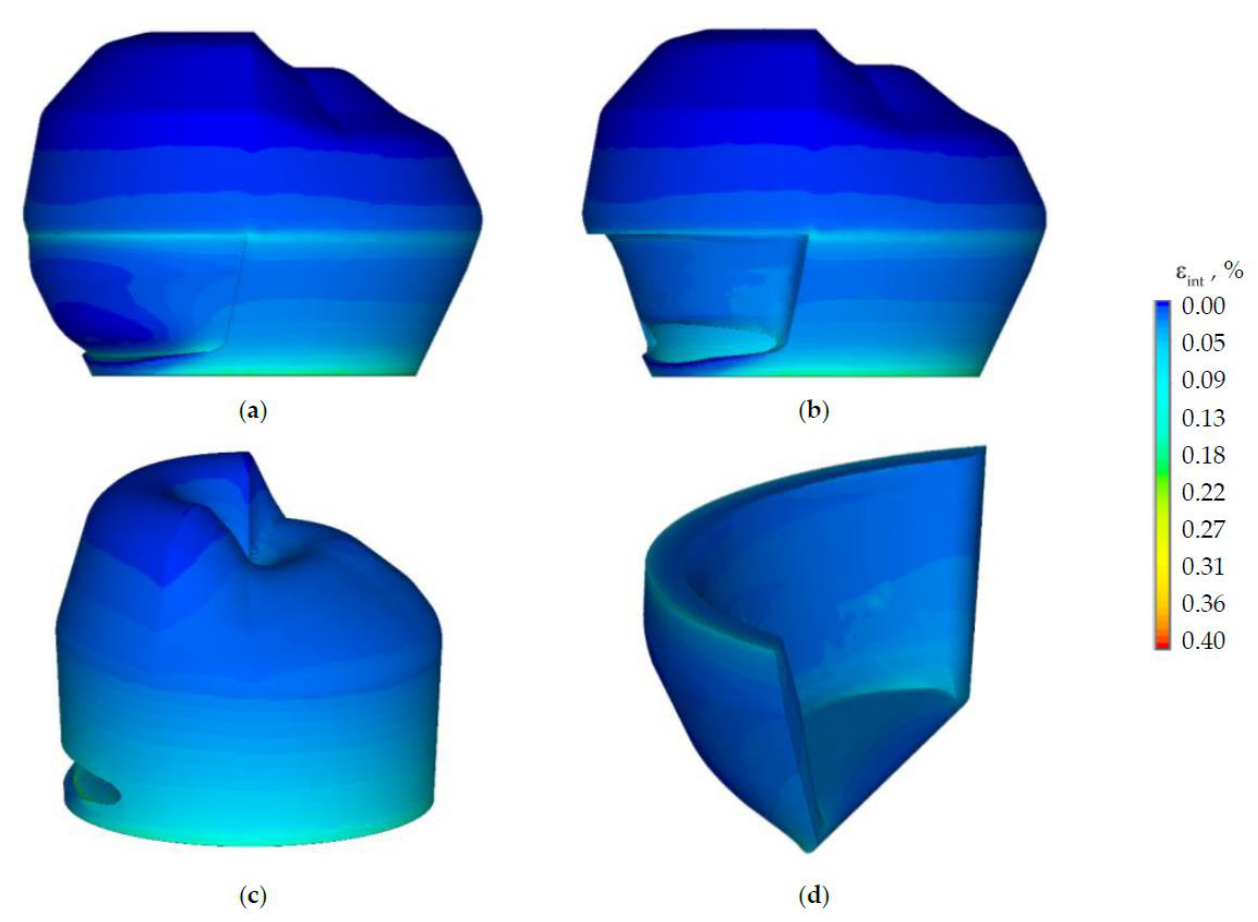
Figure 9. Strain: ( a ) is tooth-inlay system; ( b ) is enamel; ( c ) is dentine; ( d ) is inlay. The maximum strain intensity is observed in the dentine near the edge of the contact interaction zone with the prosthetic inlay. The strain intensity is lower by two or more times on the rest of the dentine volume. The max ε int in the enamel is observed near the cervical area of the tooth. The max ε int in the prosthetic inlay is located on the lower surface near the edge of the contact zone. This effect can be eliminated by: changing the geometry of the prosthetic inlay; the selection of material and refinement of the finite element model. A dependence of the strain maximum intensity on the load level is shown in Figure 10. NCCL. The maximum influence on the nature of the distribution and the level of